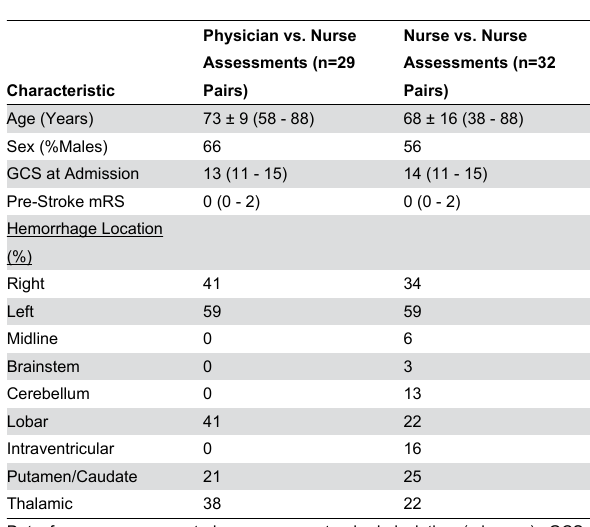
Table 1. Patient